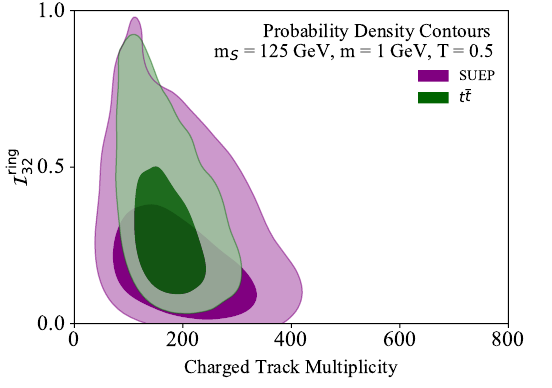
Figure 24 . The same observables as (cid:12)gure 22, but comparing the t (cid:22) t sample (green) to the m = 1 GeV, T = 5 GeV SUEP sample